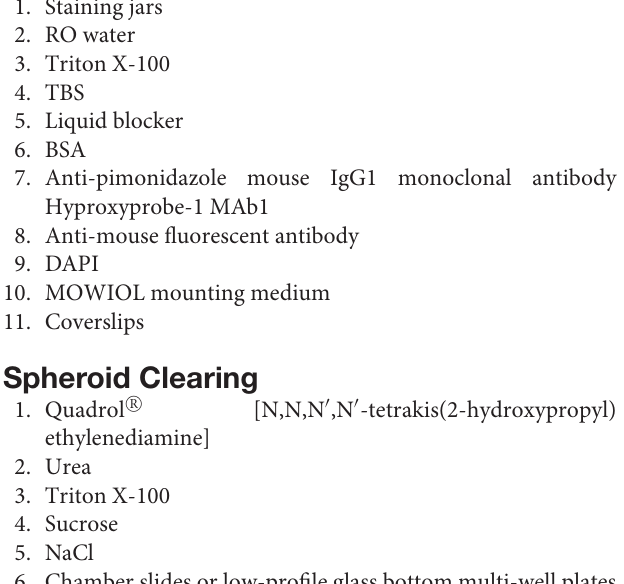
protocols suitable for the cells of interest, including patient- derived